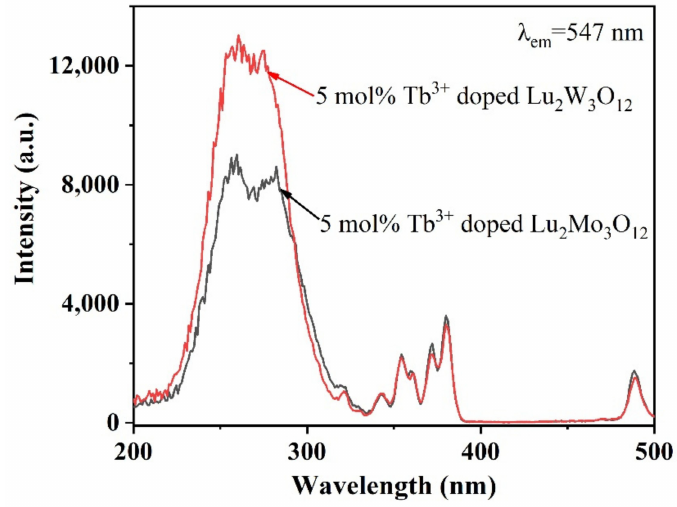
Figure 9. Comparison of PL excitation spectra of 5 mol% Tb 3+ -doped Lu 2 W 3 O 12 and Lu 2 Mo 3 O 12 phosphors prepared at 1000 ◦ C.